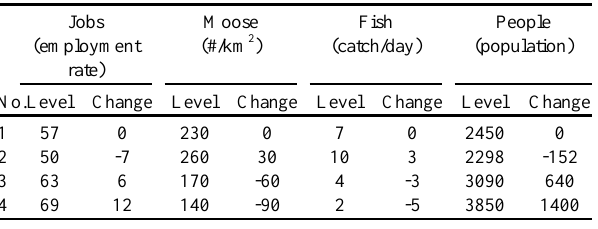
Table 1 . Attributes and Levels in the Choice